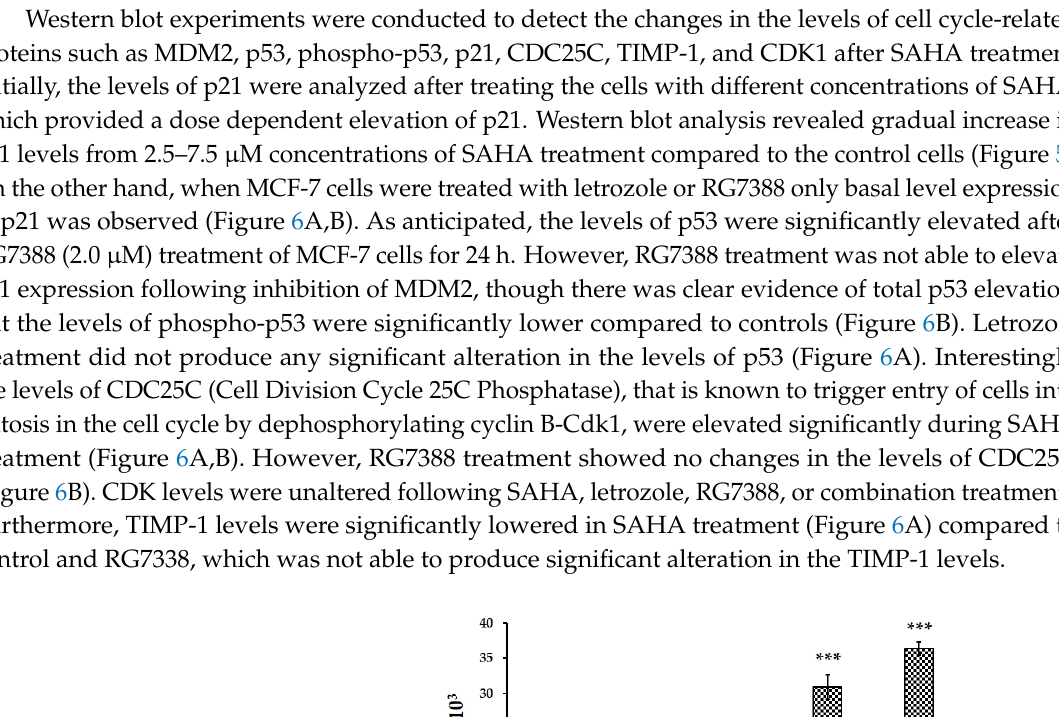
Figure 4. Inhibitory effects of SAHA and RG7388, in individual or combinations treatments, on MCF-7 cell migration during scratch assays. Representative images of MCF-7 cells captured at 0, 12, 24, and 36 h of treatment with different drugs. ( A ) Cells treated with 0.5, 2.5, 5.0, and 7.5 µM of SAHA. ( B ) Cells treated with 1.0, 2.0, 2.5, and 5.0 µM of RG7388. ( C ) Cells treated with SAHA and RG7388 (2.0 µM) in combinations.